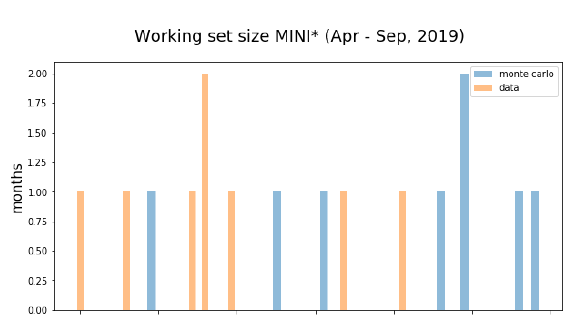
Figure 2. Monthly global working set size for analysis jobs using MINIAOD and MINIAODSIM data tiers. Data obtained from MONIT [6].